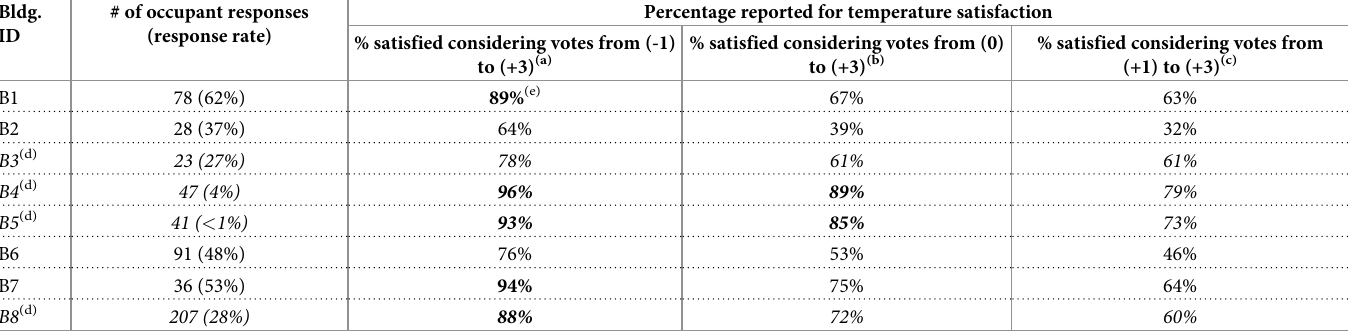
Table 3. Temperature satisfaction by